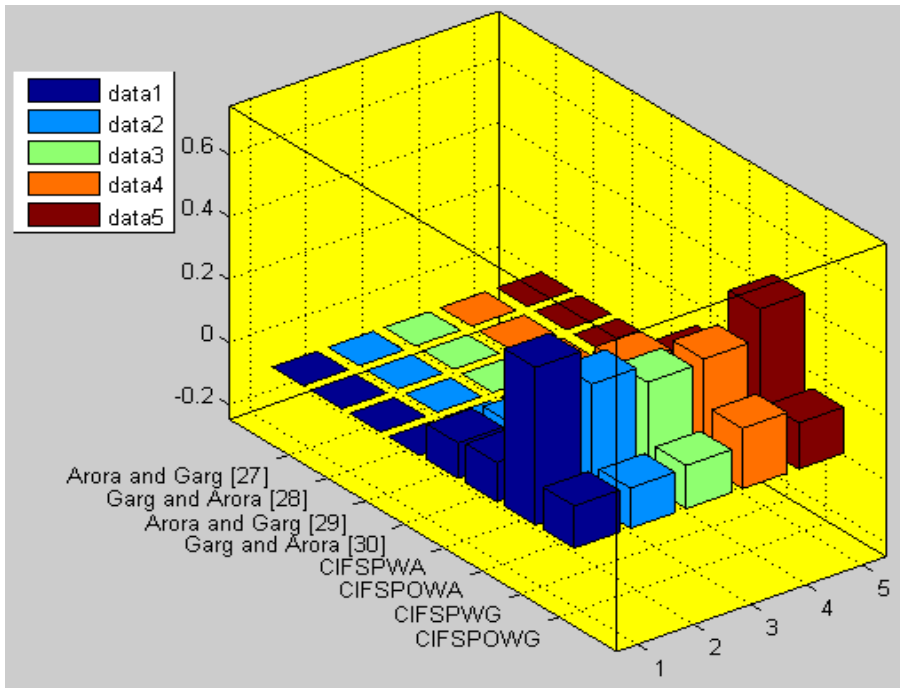
Figure 4. Graphical expressions of the information in Table 12. Table 12. Comparative analysis of the existing and elaborated operators.